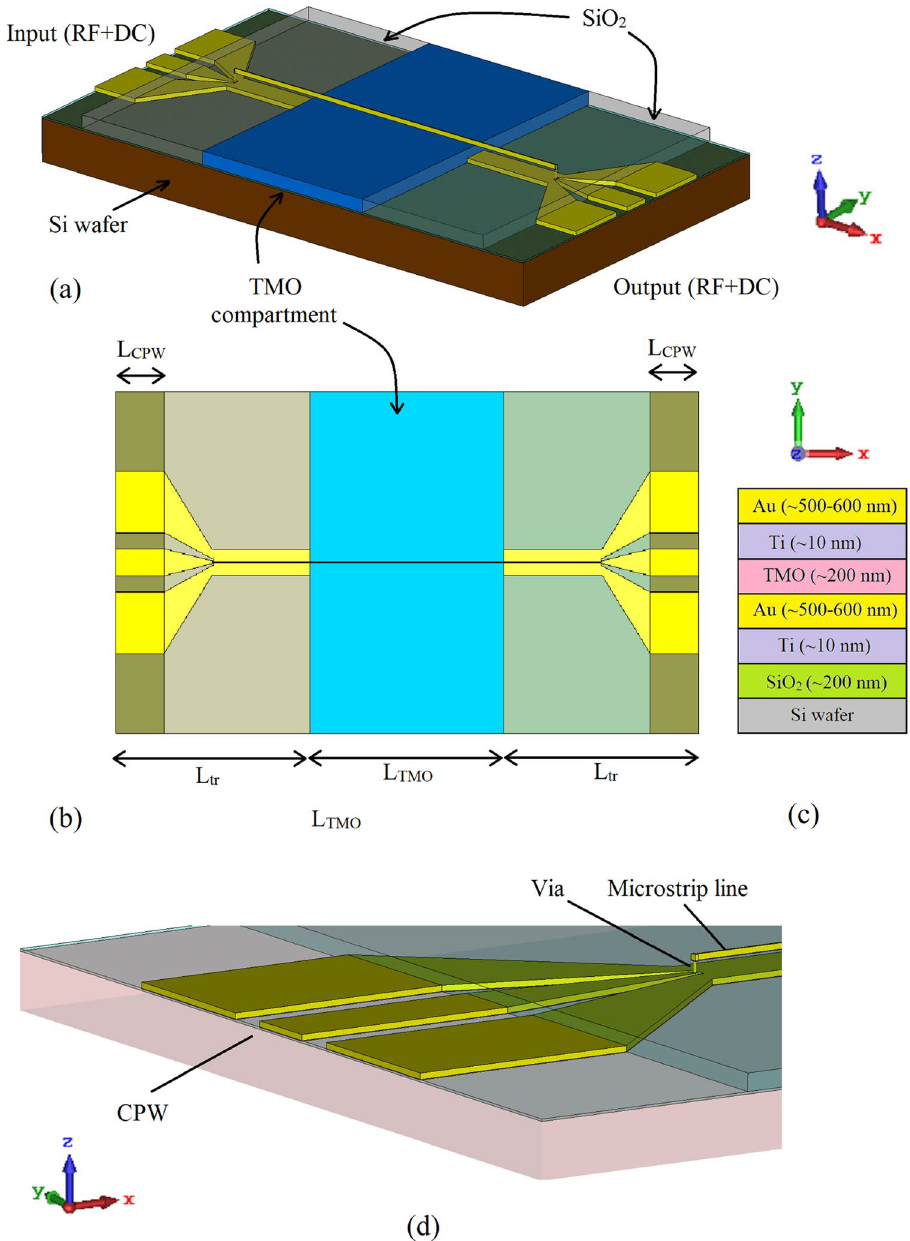
Figure 3. Switch structure: ( a ) perspective view, ( b ) top view, ( c ) material stack, and ( d ) magnified view of CPW-microstrip